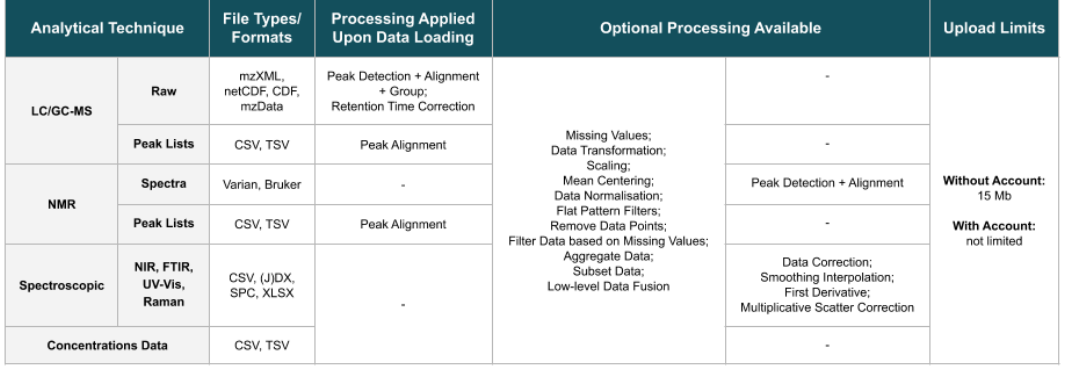
Figure 2. Summary of the file formats/types of the different analytical techniques supported, the processing methods performed on the respective data after data loading, further optional processing methods that can be performed at a later stage, and limits on the sizes of uploaded